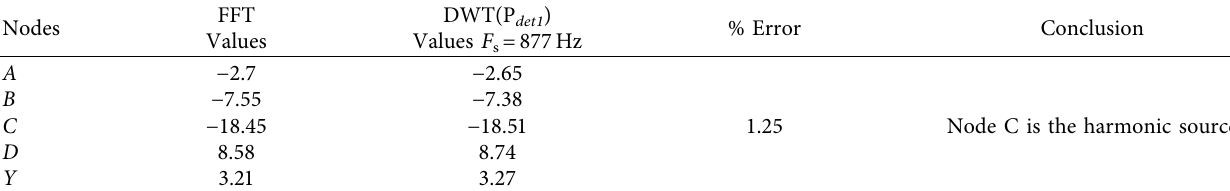
Table 3: 3rd harmonic current component contributed by the nonlinear